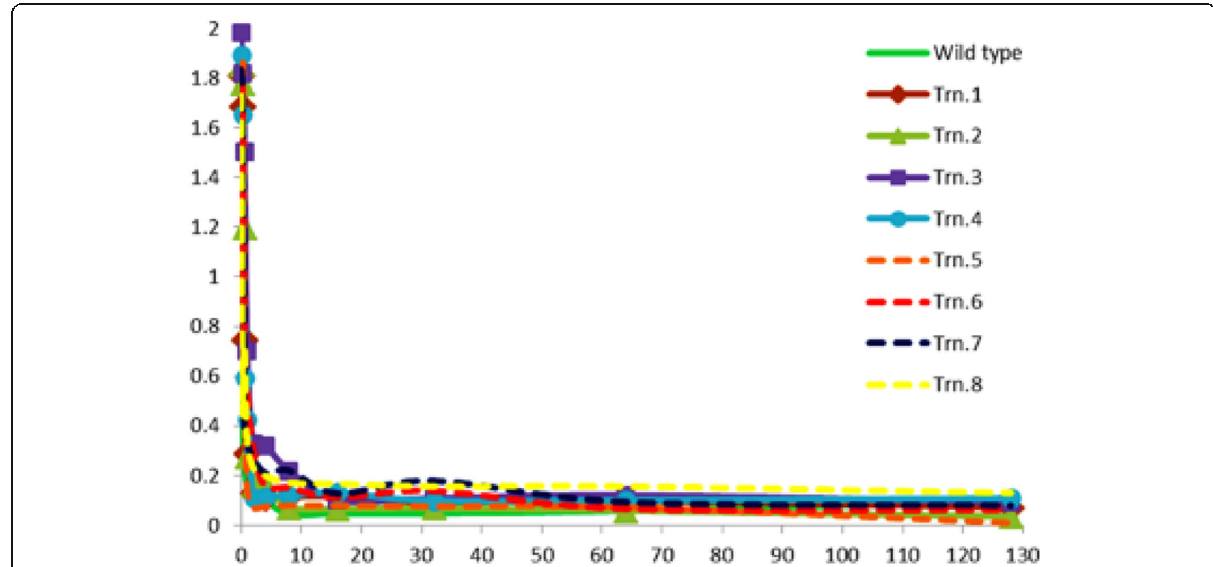
Fig. 6 Broth microdilution assay of the generated strains against fluconazole. WT, wild type strain CAF4-2; Trn.1 to Trn.8, Candida strains carrying truncations 1 – 8. Fluconazole concentrations from 0 to 128 μ g/ml (0, 0.25, 0.5, 1, 2, 4, 8, 16, 32, 64, and 128 μ g/ml) were used. All the strains are showing sensitivity to fluconazole, similar to the wild type